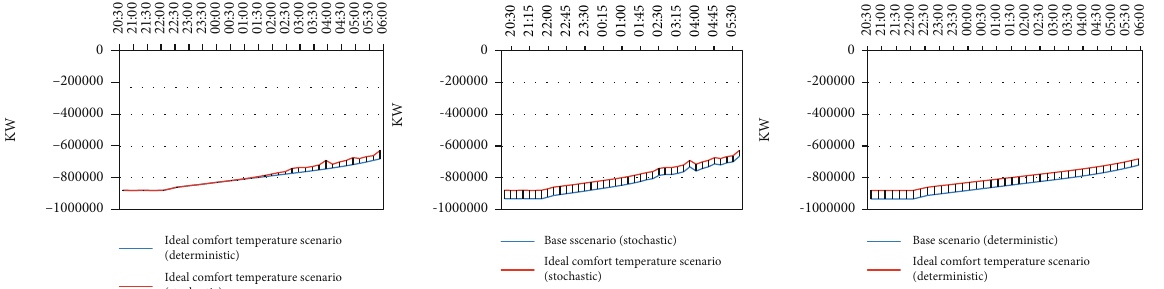
Figure 27: Di ff erent modes in the ideal comfort temperature scenario (night).